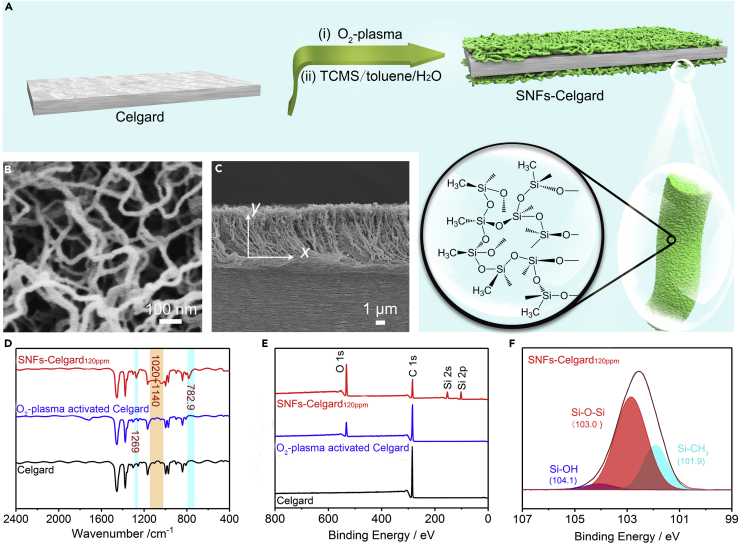
Preparation and Characterization of SNFs-Celgard Separators(A) Schematic illustration of preparation of the SNFs-Celgard separator by O2-plasma activation and subsequent SNFs growth, and chemical structure of the SNFs.(B and C) (B) SEM and (C) cross-sectional SEM images of the SNFs-Celgard120ppm separator. See also Figures S2 and S3.(D–F) (D) FTIR spectra, (E) XPS spectra, and (F) high-resolution Si 2p spectrum of the separators. See also Figure S5 and Table S2.